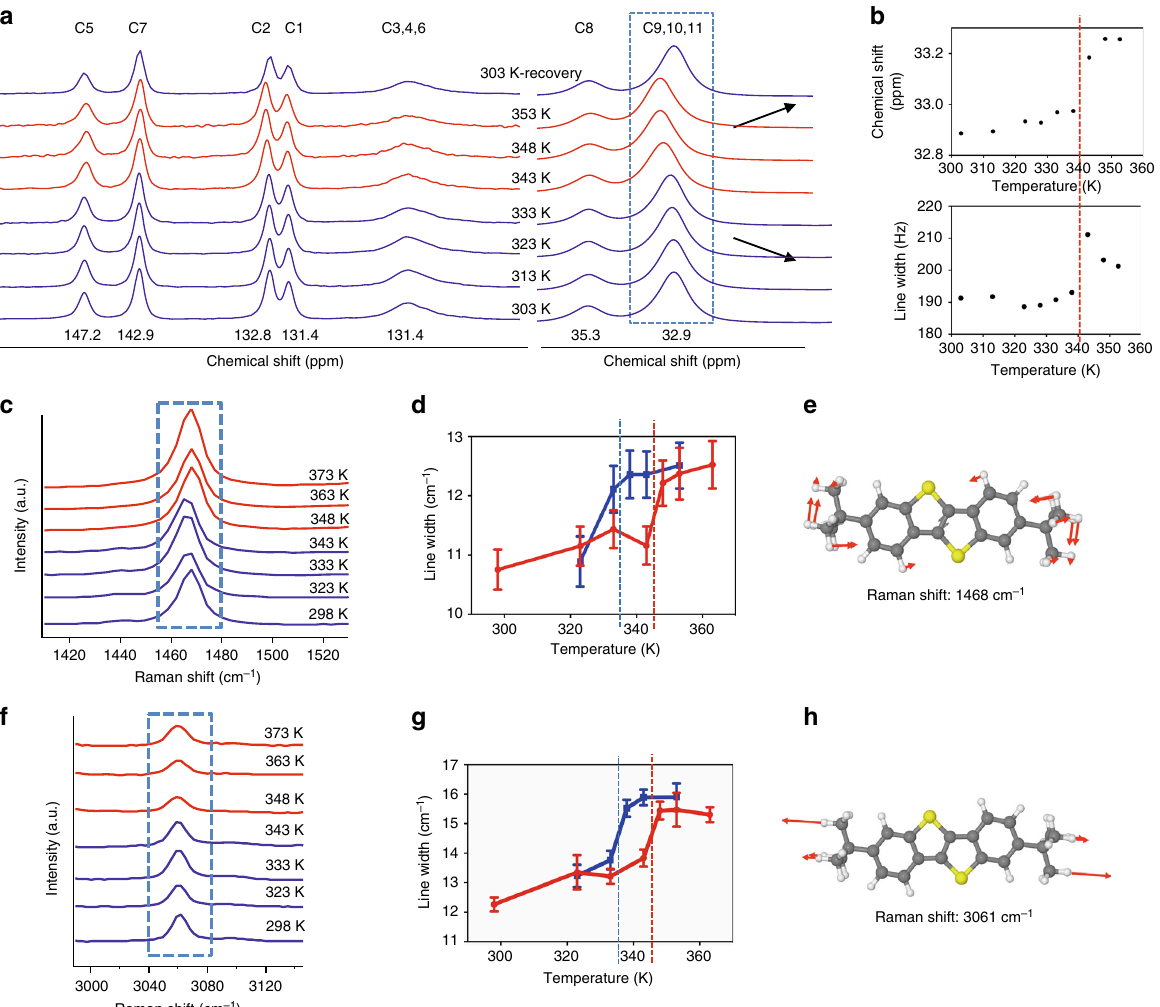
Fig. 3 Experimental evidence showing side chain disorder in ditBu-BTBT. a Variable temperature NMR spectra of ditBu-BTBT powder sample. Blue and red spectra correspond to LT and HT forms, respectively. The peak that corresponds to 32.9 ppm was identi fi ed as the side chain carbons, C9, C10, and C11. b Both the chemical shift position and the linewidth of the side chain carbons show a clear increase near the predicted transition temperature from DSC (red dashed line). c Variable temperature Raman spectra for Raman shift 1468 cm − 1 . d Plot of linewidth as a function of temperature for Raman shift 1468 cm − 1 . e DFT predicted vibrational mode showing C-H bond bending in the side chains. f Variable temperature Raman spectra for Raman shift 3061 cm − 1 . g Plot of linewidth as a function of temperature for Raman shift 3061 cm − 1 . h DFT prediction showing C-H asymmetric stretching in the side chains. Blue and red spectra correspond to LT and HT forms, respectively. A clear increase in the linewidth is observed at the predicted transition temperatures for both Raman shifts (red dashed line: onset transition temperature during heating, blue dashed line: onset transition temperature during cooling). The error bars are calculated from the Gaussian curve fi tting of the Raman